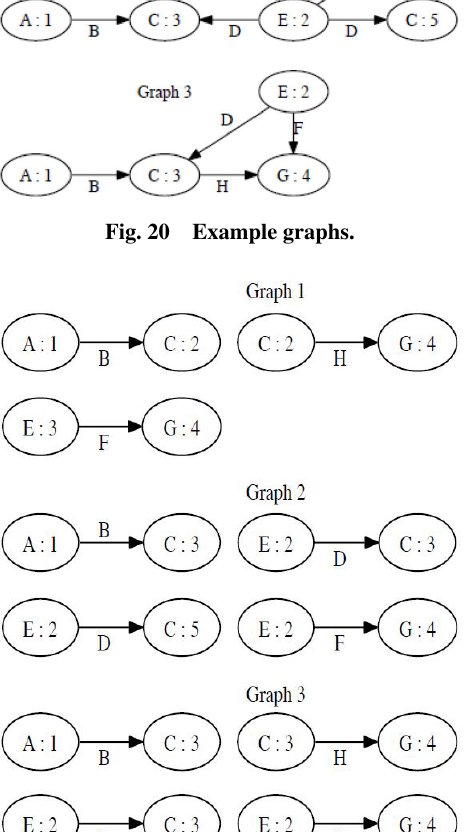
Fig. 21 Single-edge subgraphs that meet support.